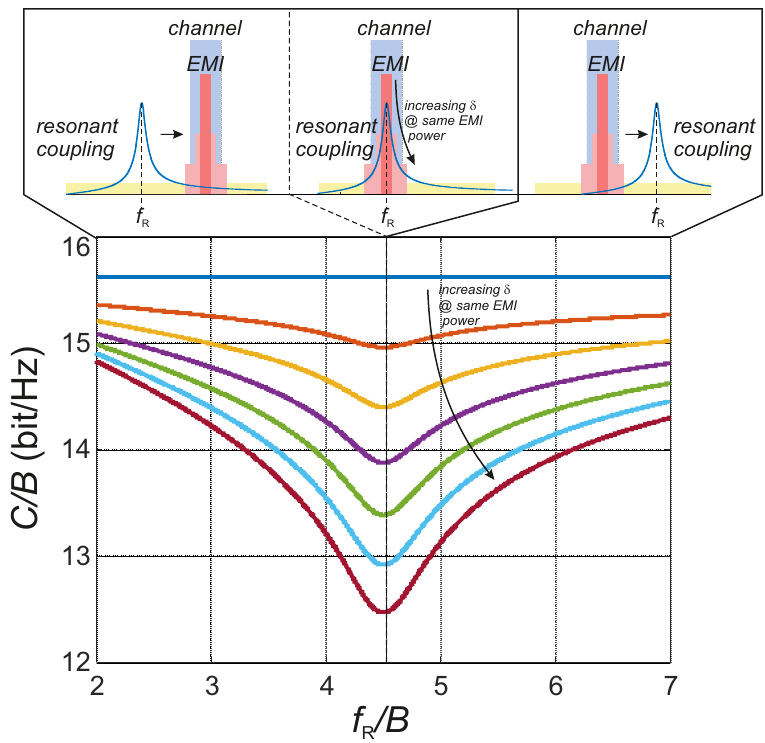
Figure 4. Normalized capacity versus resonant frequency f R / B for a communication channel with bandwidth B = ( f 1 , f 2 ) in the presence of EMI